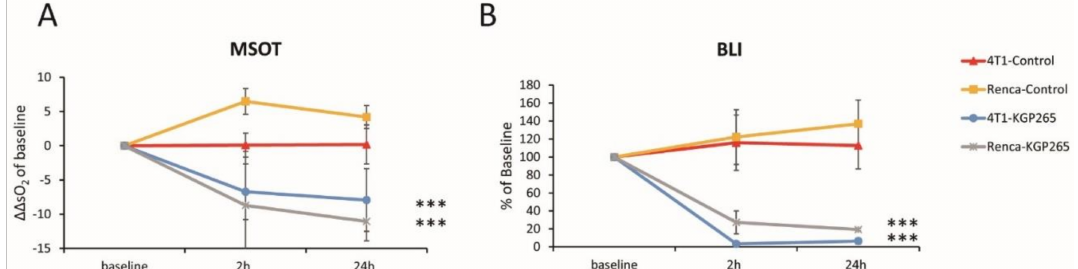
Figure 6. BLI and OE-MSOT responses to KGP265 were strongly correlated in different tumor types. ( A ) The tumor oxygen supply capacity is determined by the amplitude of the vascular response ( ∆ sO 2 ) to the oxygen gas breathing challenge. A change in the ∆ sO 2 ( ∆∆ sO 2 ) is indicative of vascular development or impairment and is shown for each tumor type with respect to the interventions at 2 and 24 h: RENCA tumors: saline control (yellow, n = 3) and KGP265 (grey n = 3) and 4T1 tumors: saline control (orange, n = 3) and KGP265 (blue, n = 4). Individual data points represent the mean ± SD. Fisher’s PLSD analysis of variance (ANOVA) indicated that 4T1 and RENCA tumors both showed a significantly reduced vascular response to the oxygen gas breathing challenge within 2 h ( p < 0.0001) of the administration of KGP265, which remained depressed at 24 h ( p < 0.001). ***, p < 0.001. ( B ) The corresponding relative BLI intensity changes observed for these tumors. Individual data points represent the mean ± SD. ANOVA based on Fisher’s PLSD indicated that the 4T1 and RENCA tumors both showed significantly reduced light emission within 2 h ( p < 0.001), which remained significantly depressed at 24 h after the administration of KGP265 ( p <